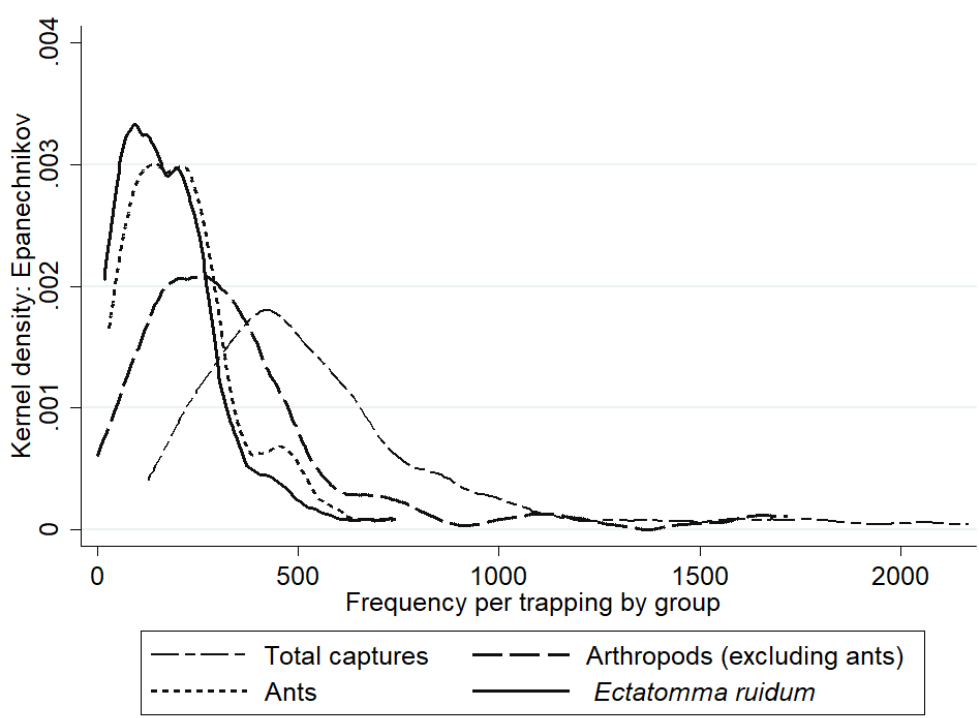
Fig 3 . Density of total captured individuals per major group of analysis. El Mira Research Center, Tumaco, Pacific Coast of Colombia,